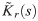
Density plot of a stationary pulse formed using the revised repulsion kernel, K˜r(s).Bright colours indicate high numbers of individuals. The number density has been normalized to 1. Parameters are identical to those for the stationary pulse observed in Fig 5(a) (M1, λ1 = 0.2, λ2 = 0.9, qr = 2.4, qal = 0, qa = 2). Note the loss of high-density subgroups within each stationary pulse. The revised repulsion kernel does not permit conspecifics to remain together as a small group without exerting a large repulsive force on each other.